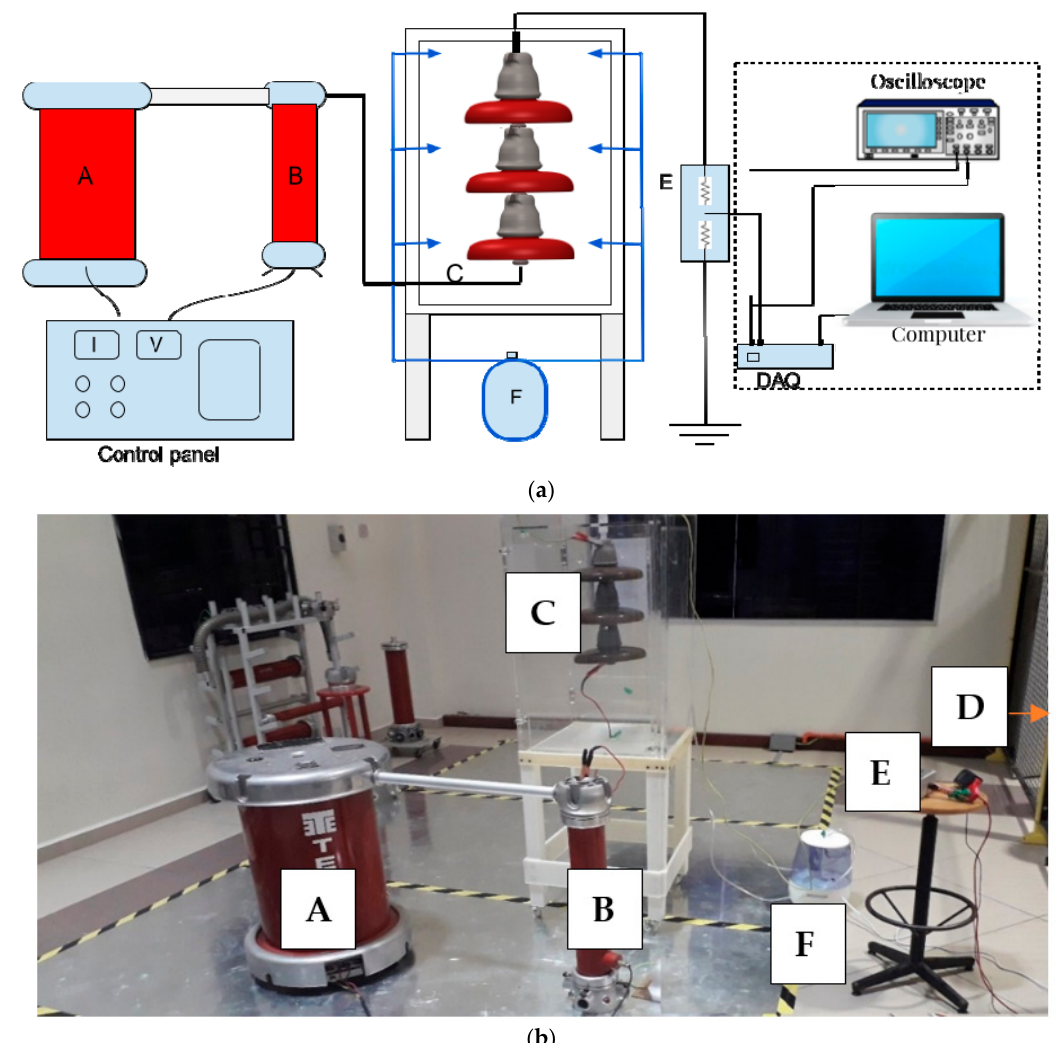
Figure 2. ( a ) Diagram of insulators’ test arrangement; ( b ) photograph of the insulators under test.